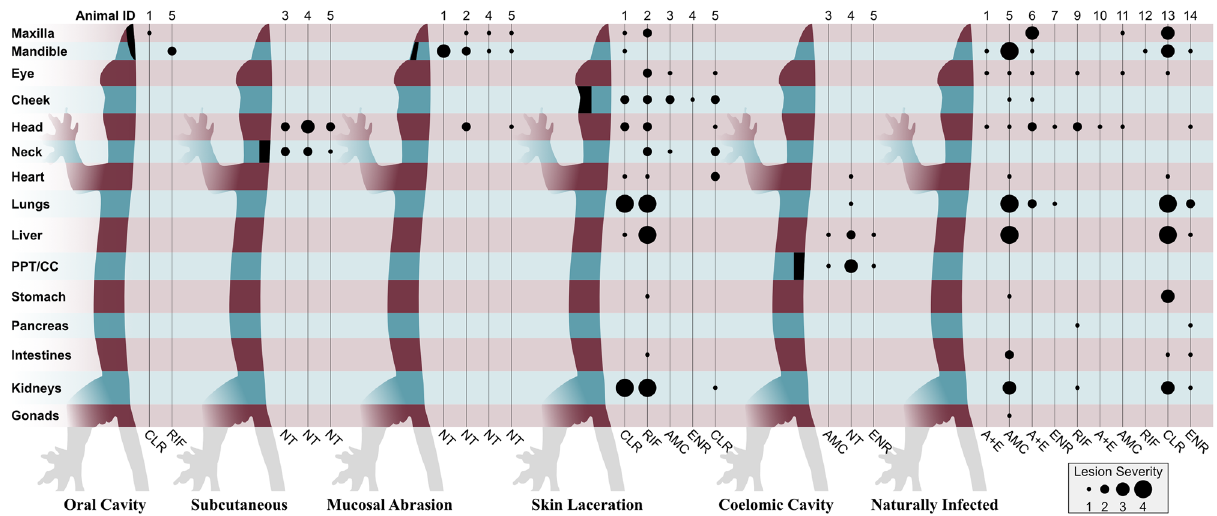
Figure 6. Histological distribution of E. lacertideformus in experimentally infected Asian house geckos per inoculation route and treatment group. The numerical values positioned at the top of the figure represent the ID of each infected gecko. The treatment administered to each gecko are abbreviated; AMC amoxicillin-clavulanic acid; A + E amoxicillin-clavulanic acid and enrofloxacin; CLR clarithromycin; ENR enrofloxacin; NT no treatment; RIF rifampicin. PPT/CC represents lesions associated with the pleural and pericardial tissues and/or the coelomic cavity. The section of black shading on the gecko represents the site of inoculation for that group. Identification of E. lacertideformus bacteria in organs/tissues are represented by the black circles. The severity of the histological lesions from 1 to 4 are denoted by the size of the